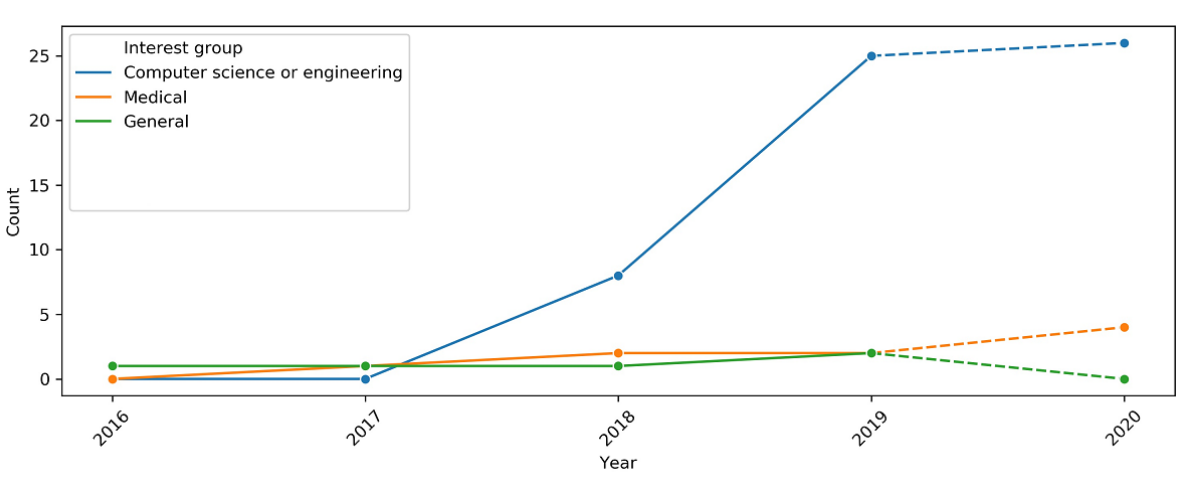
Figure 3. Trend of blockchain personal health record articles by interest group. The trend from 2019 to 2020 (represented by dashed lines) is a projection because only data from the first half of the year 2020 was available at the time of the search. Count refers to the number of articles published in that year.